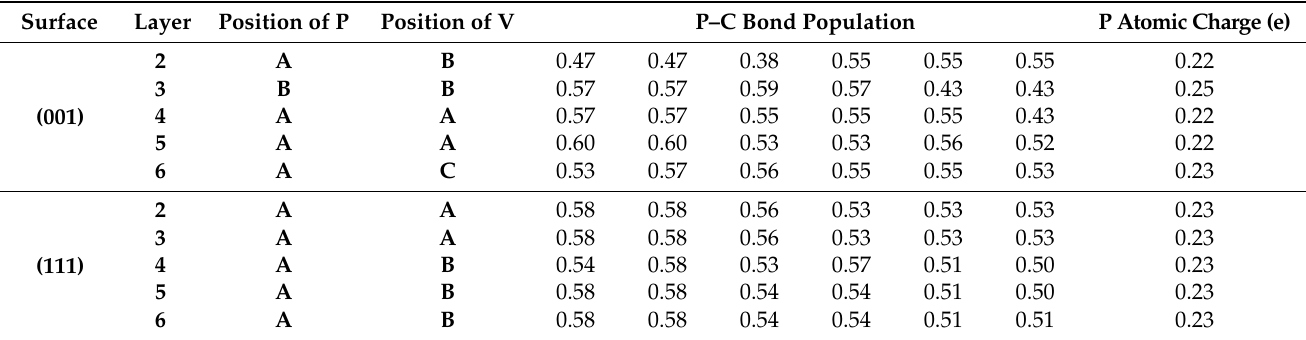
Table 6. Atomic charges and electron bond population of the PV complex with the lowest formation energy in each layer. Surface Layer Position of P Position of